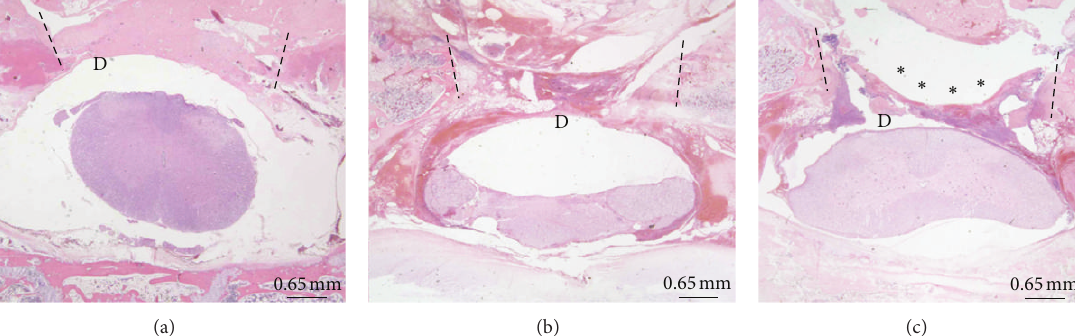
Figure 3: Histological sections of the laminotomy sites (between dotted lines) at one week ((a) control, group I; (b) HA-CMC, group II; (c) P-ALMC, group III). Group III showed that the clear space (asterisks) formed by the interpositional barrier of P-ALMC between the dura (D) and the posterior soft tissue is maintained in a comparison of groups I and II (H&E, × 1.25).